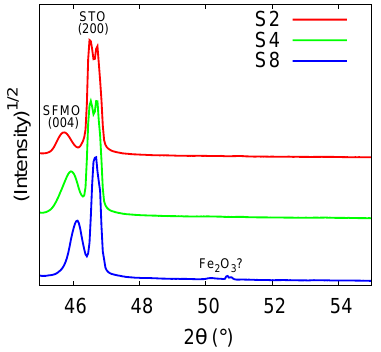
Fig. 1. Detail of the θ -2 θ -scans between 45 ◦ and 55 ◦ .